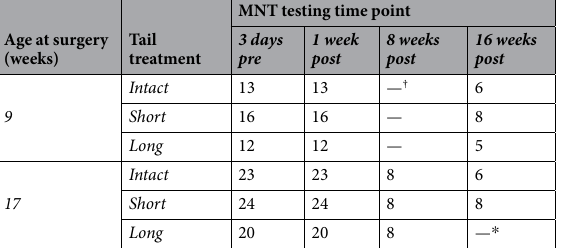
Table 1. Overview of the number of animals from which mechanical nociceptive threshold (MNT) data were collected at each individual time point (number of days/weeks in relation to the time of tail resection) ( † data missing due to behavioural non-compliance of animals; * data missing due to technical failure of Pressure Application Measurement